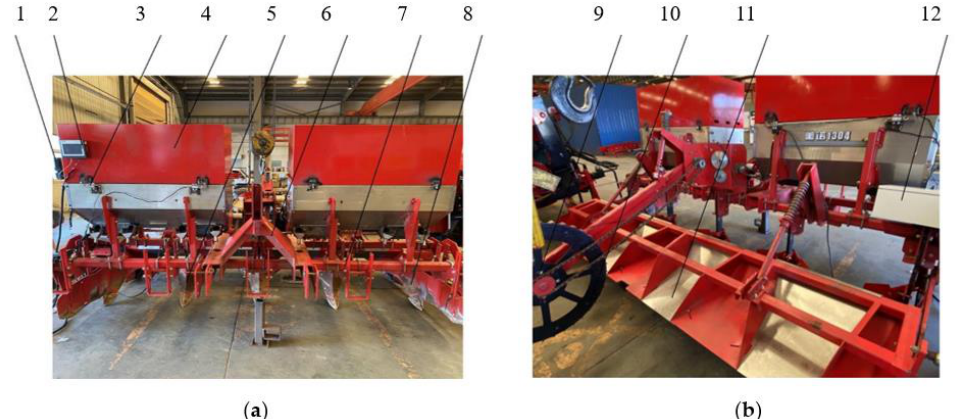
Figure 1. The mechanical structure diagram of variable formula fertilizer. If there are multiple pan- els, they should be listed as: ( a ) Forward graph; ( b ) Backward graph. (1) Servo motor, (2) Vehicle-mounted control terminal, (3) Pressure sensor, (4) Fertilizer tank, (5) Soil plow, (6) Suspension mechanism, (7) Frame, (8) Trough wheel type fertilizer device, (9) Speed sensor, (10) Ground wheel, (11) Plastic device, (12) Programmable Logic Controller (PLC controller)